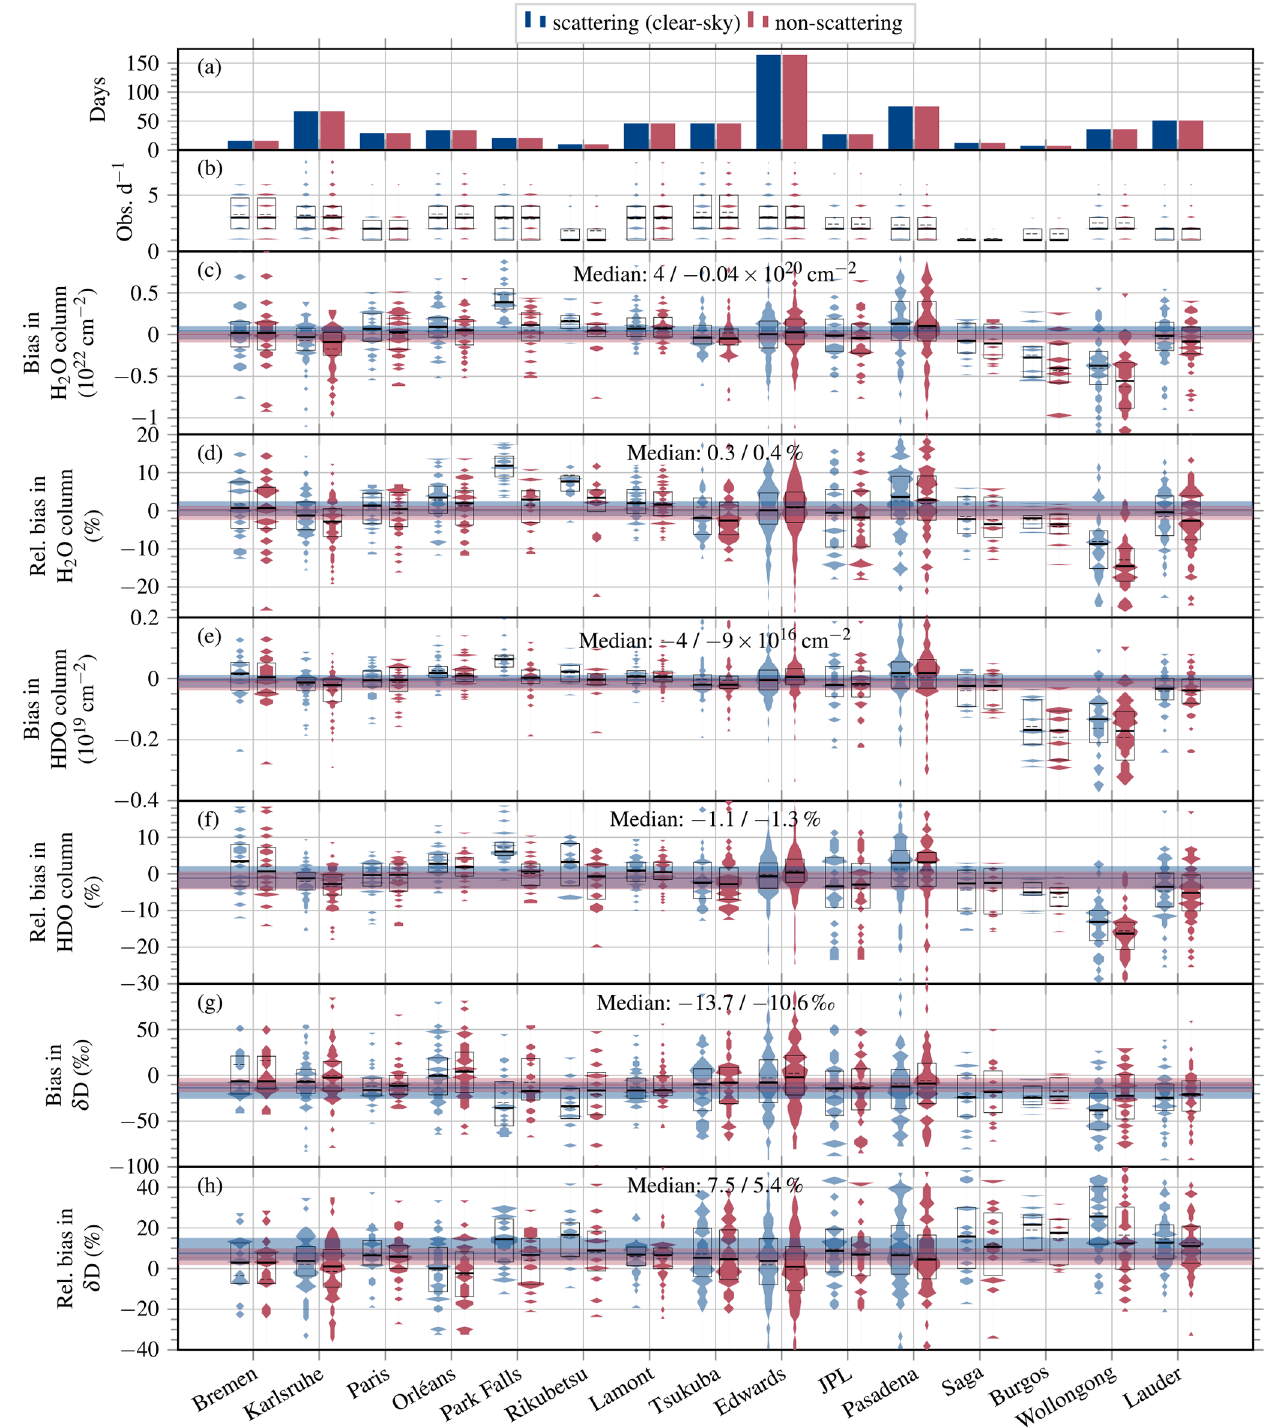
Figure 10. (a) Number of days with observations, (b) observations per day, (c) bias in H 2 O columns, (d) relative bias in H 2 O columns, (e) bias in HDO columns, (f) relative bias in HDO columns, (g) bias in δ D, and (h) relative bias in δ D for the scattering retrieval (blue) and the non-scattering retrieval (red). The violin plots visualise the distribution of differences between TROPOMI and TCCON, the boxplots mark quartiles and the dashed lines inside the boxes show the mean. Coloured horizontal lines denote station-to-station medians and the shading around them the station-to-station